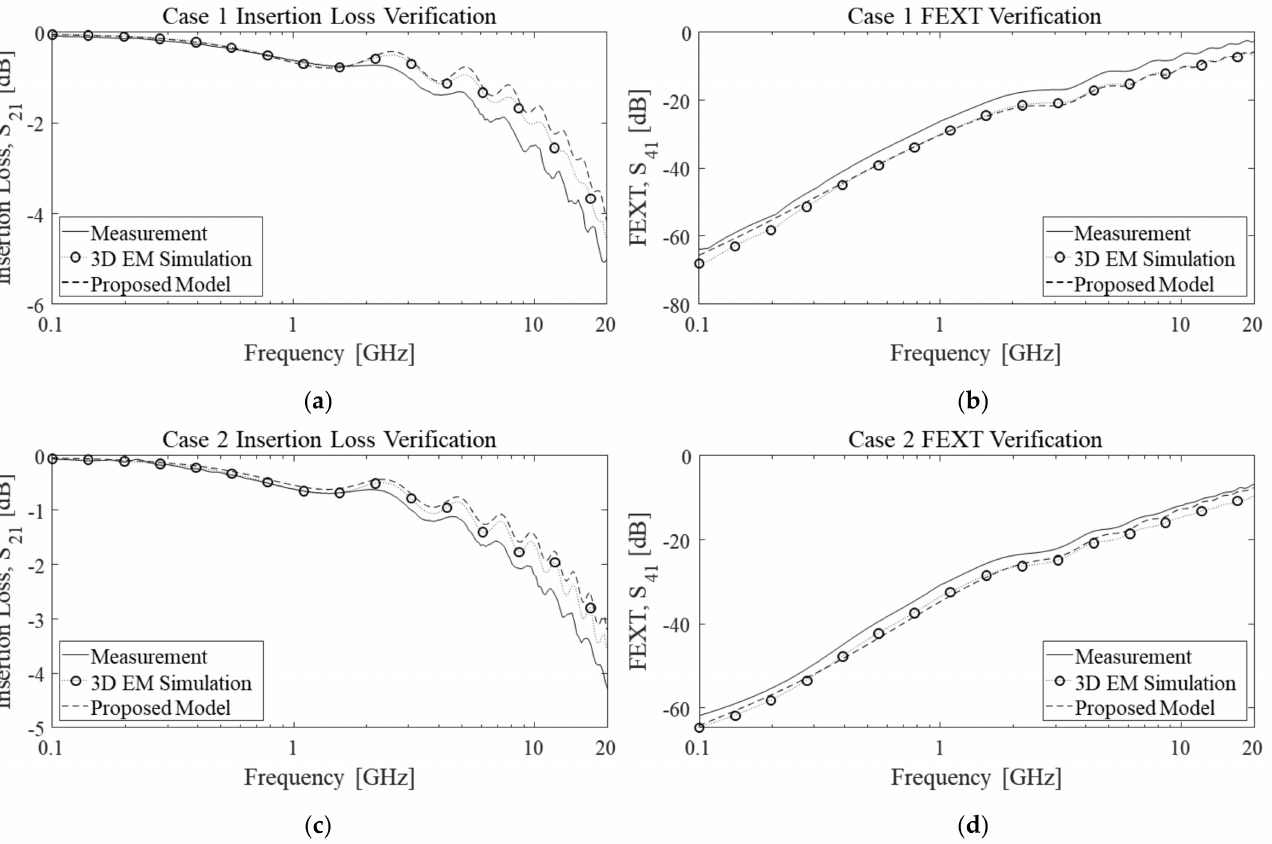
Figure 8. Frequency domain verification of the proposed model by comparison of VNA measurement and 3D EM simulation. The proposed model of case 1 is verified for ( a ) insertion loss and ( b ) FEXT; and the proposed model of case 2 with different tab designs is verified for ( c ) insertion loss and ( d )